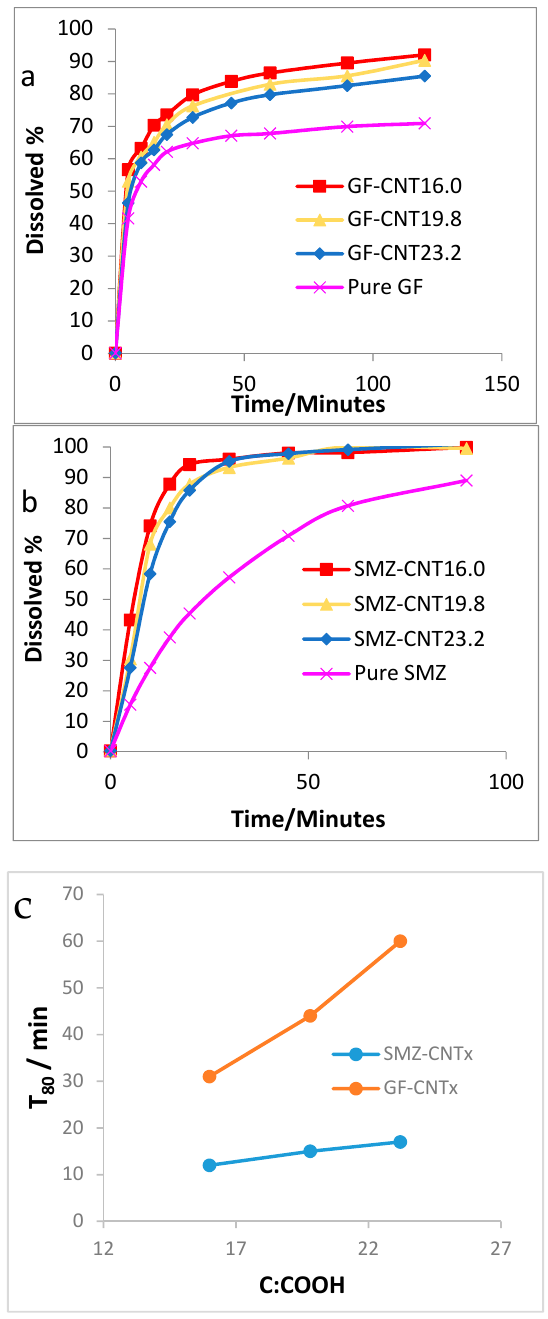
Figure 6. ( a ) Dissolution of GF-CNTs, ( b ) dissolution of SMZ-CNTs, and ( c ) time to reach 80% dissolution for drugs (t80) with a degree of functionalization of CNTs.